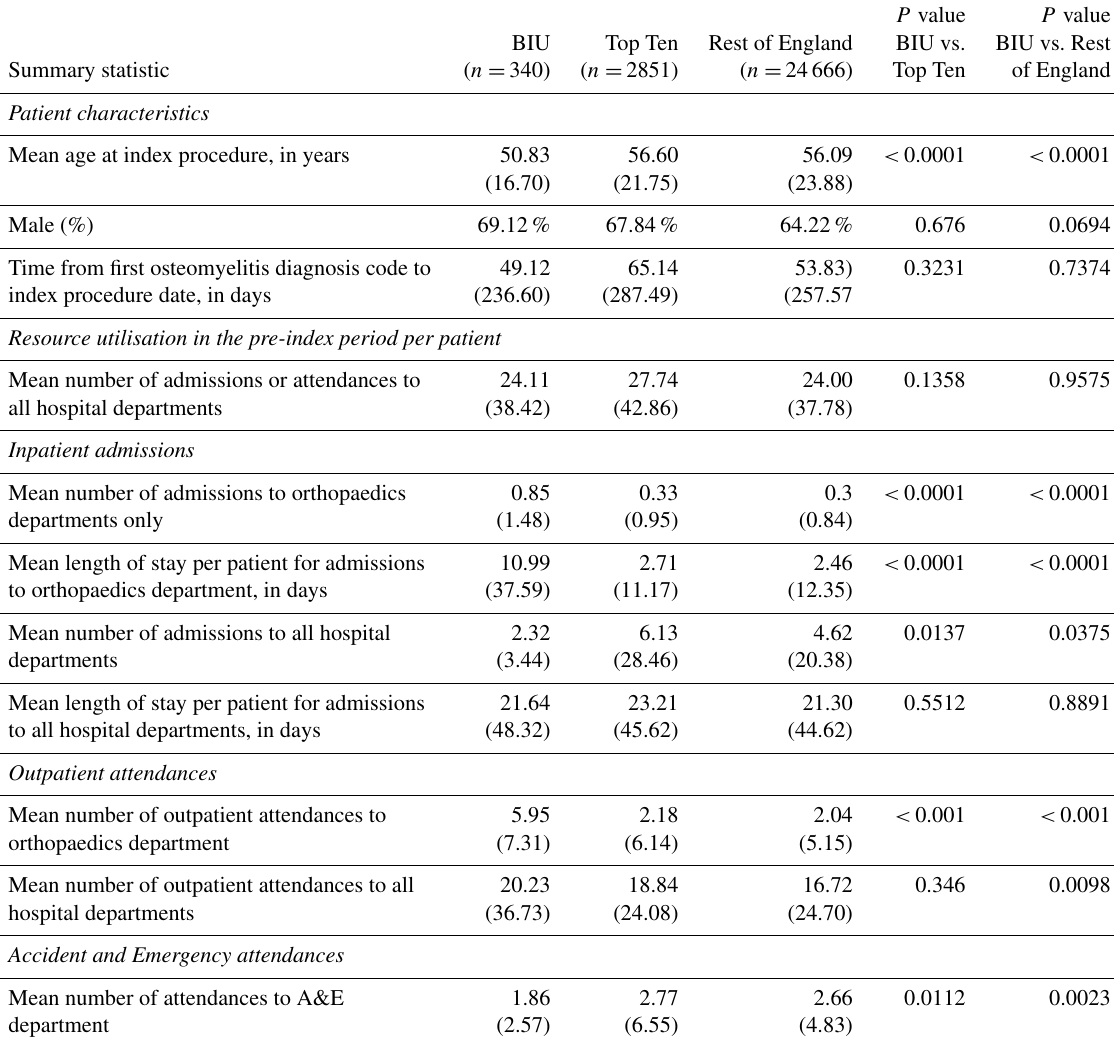
Table 1. Characteristics of patients included in the study and healthcare resource utilisation in the pre-index period (the 2 years before the index osteomyelitis procedure). Group One is the Bone Infection Unit (BIU). Group Two contains the 10 hospitals in England (excluding the BIU) with the highest number of osteomyelitis cases treated surgically in the study period. Group Three includes all remaining English hospitals treating osteomyelitis (excluding the BIU and the next 10 busiest hospitals). Figures represent the mean and (standard deviation) unless otherwise